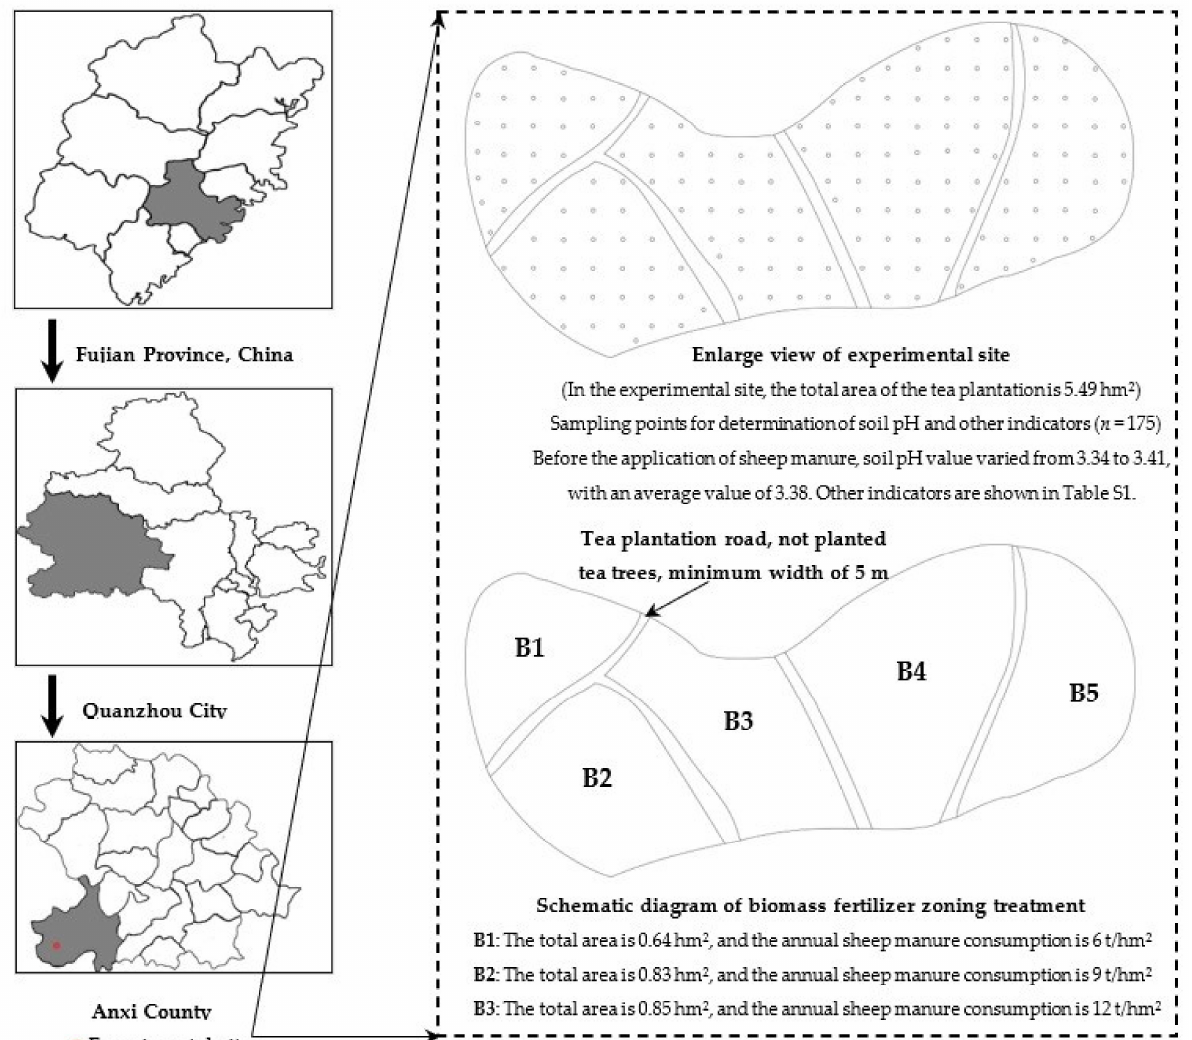
Figure 12. Schematic diagram of the experimental site and tea plantation subdivision from 2017 to